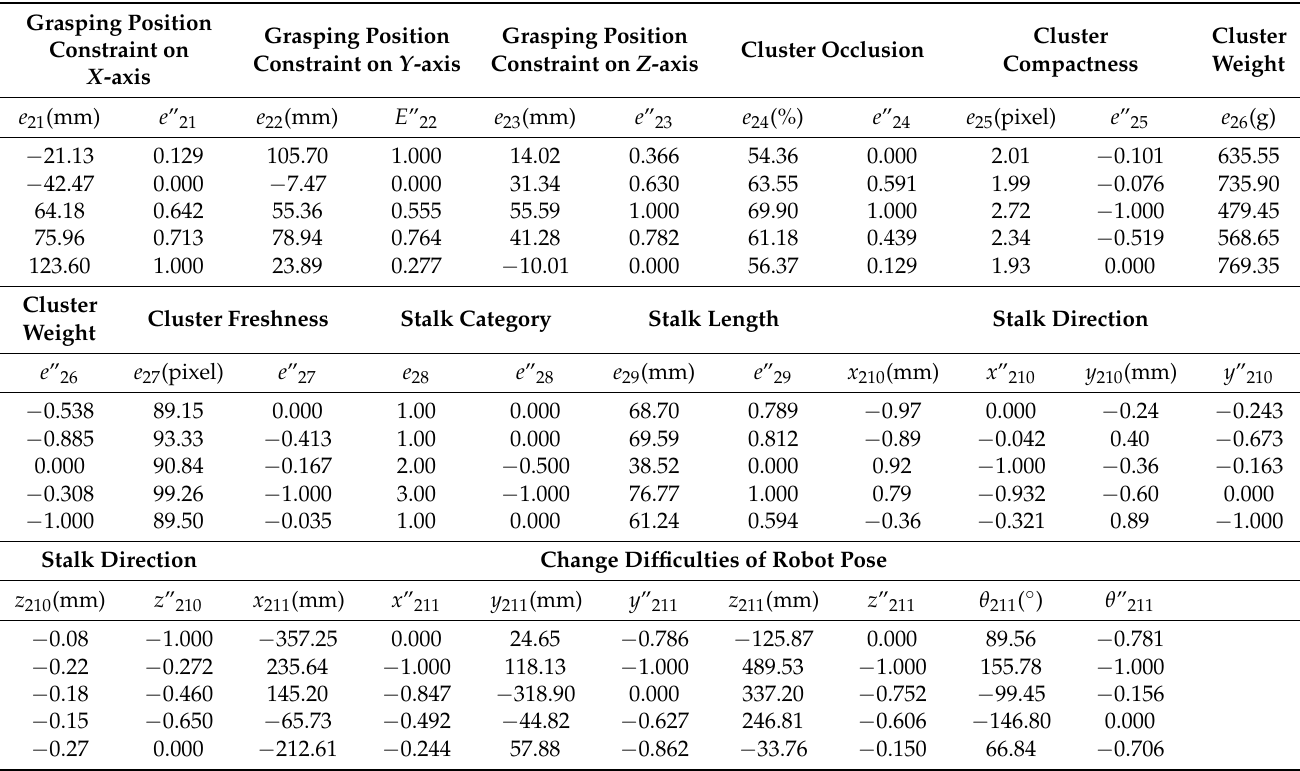
Figure 11. Original images for experiments in the four groups. Table 1. Experimental data with main differences of grasping position